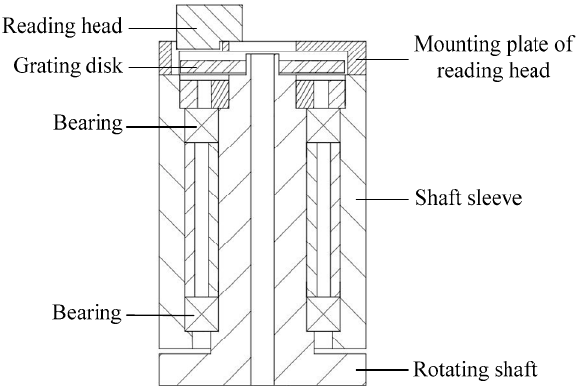
Figure 1. Diagram of the rotation joint.